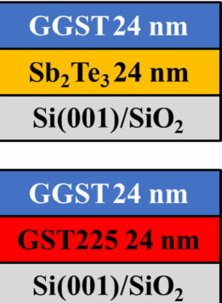
Figure 1. Schematics of the double-layer